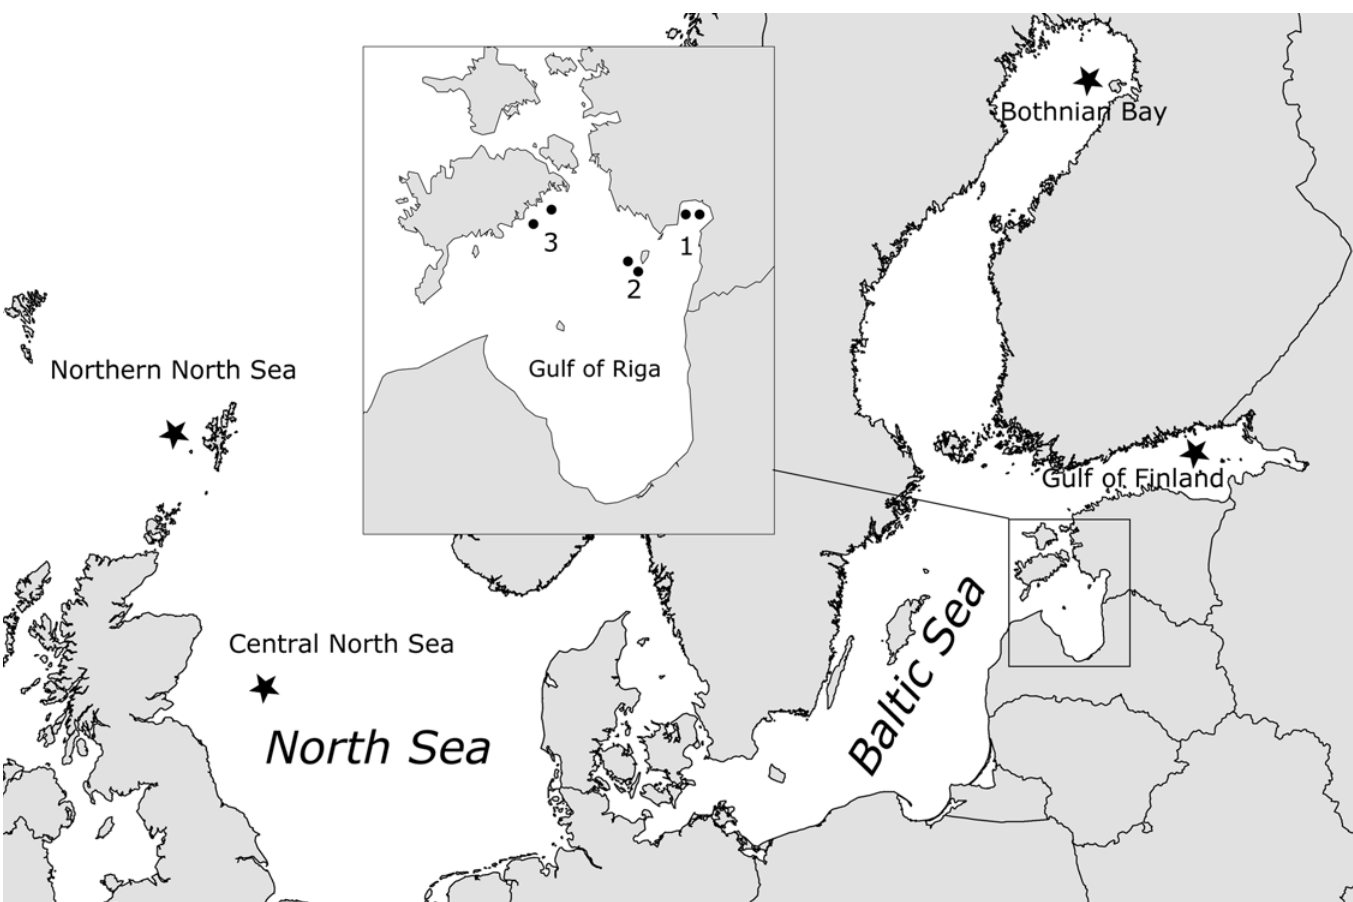
Fig 1. Clupea harengus sampling locations in the Gulf of Riga (inset) and adjacent areas in the Baltic Sea and the North Sea. Numbers show sampling locations for respectively 1. Pärnu Bay, 2. Kihnu Island, and 3. Saaremaa. Four stars show origin of collections from